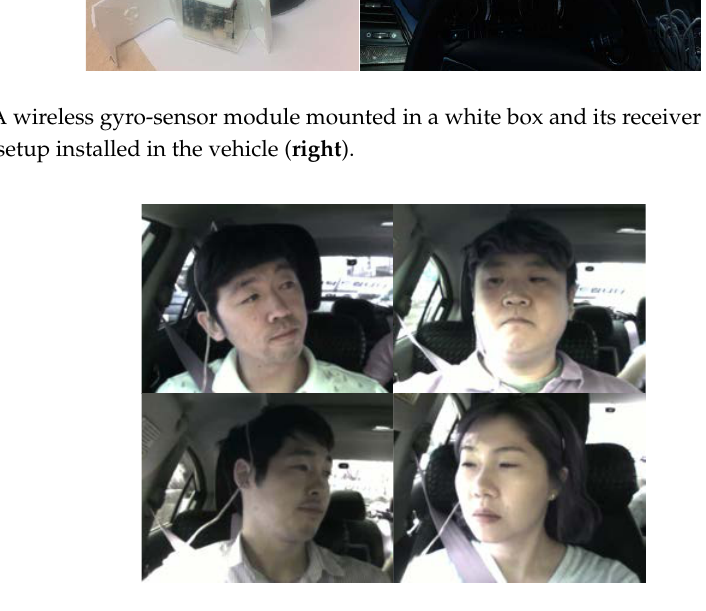
Figure 9. Images for four subjects taken from our custom-made driving face database. The driver often nods without looking at the side and rear mirrors. In our custom-made DB, subjects are asked to move their head to the extreme head poses while driving naturally. The yaw, pitch, and roll of the extreme poses are greater than 30° for four subjects and the image size is 640 × 480 with 500 frames length for each case. Table 3. Head pose ranges of four subjects in our custom-made face database.